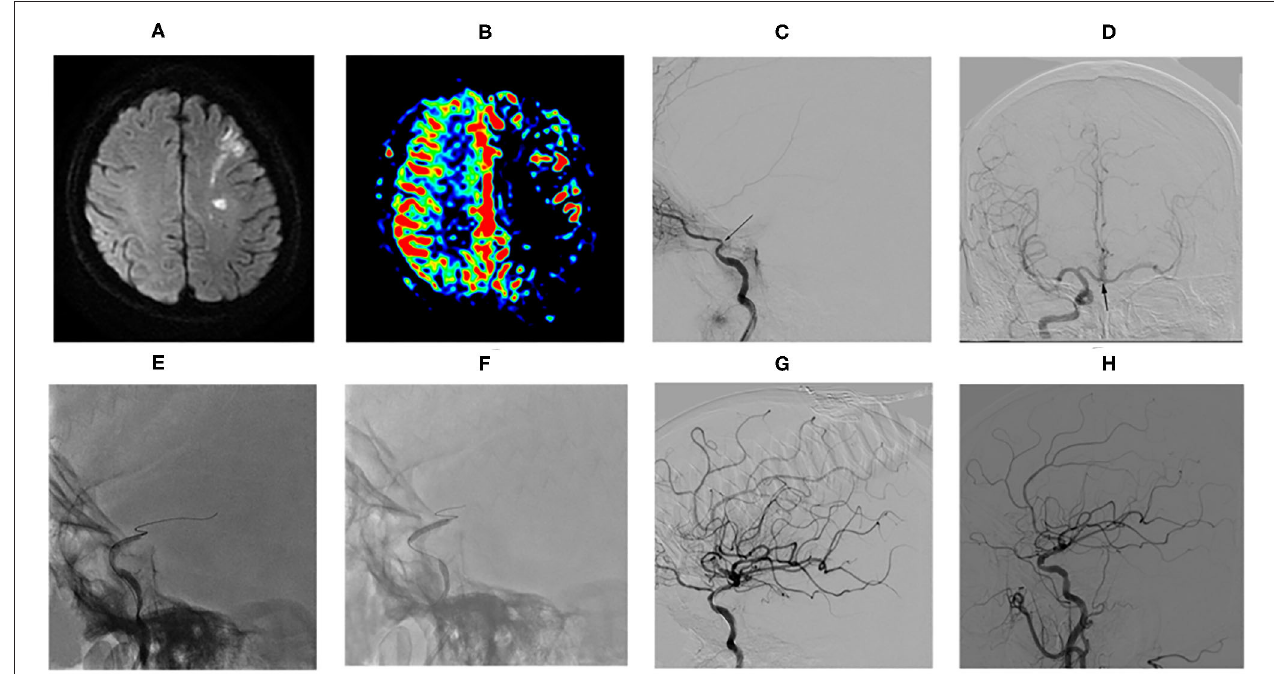
FIGURE 1 | Example of drug-coated balloon (DCB) dilatation for nonacute sICATO and follow-up. (A) MRI revealed left watershed infarction. (B) ASL showed left cerebral hemispheric hypoperfusion in the ICAO territory. (C) DSA confirmed the left internal carotid artery terminus occlusion ipilaterally to the infarcts (arrow). (D) DSA showed anterior communicating arteries (arrow). (E) Predilatation with a conventional balloon. (F) DCB dilatation after predilatation. (G) Angiographic result after the procedure. (H) Angiographic result at follow-up of 3.0 months.